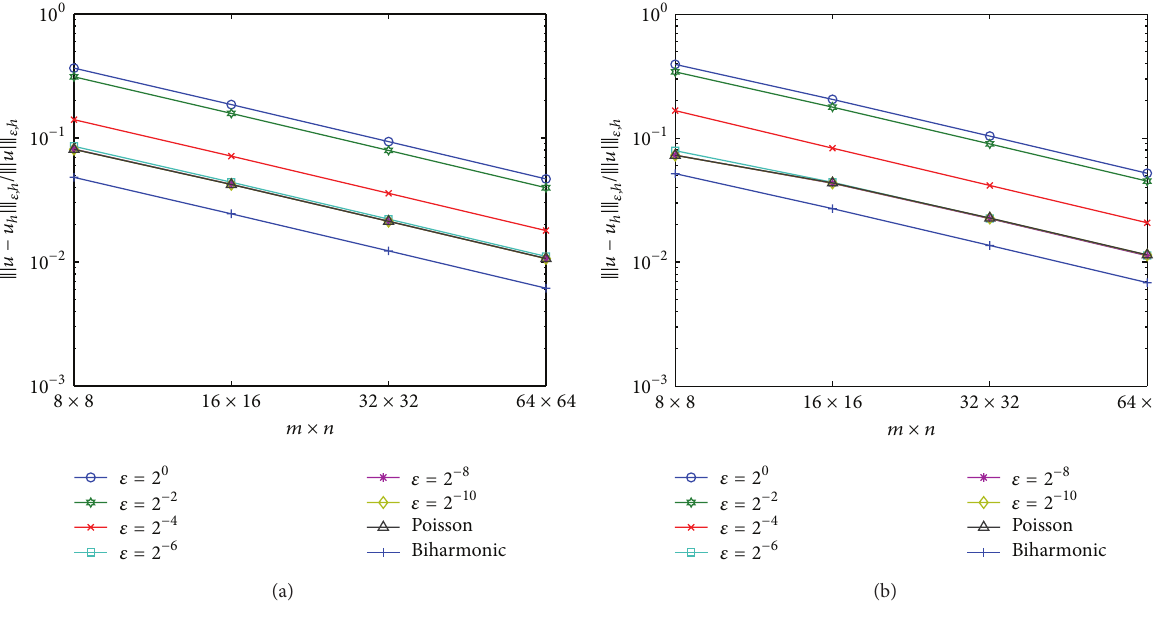
Figure 5: The errors ‖|𝑢 − 𝑢 ℎ |‖ 𝜀,ℎ /‖|𝑢|‖ 𝜀,ℎ under mesh 1 (a) and mesh 2 (b).